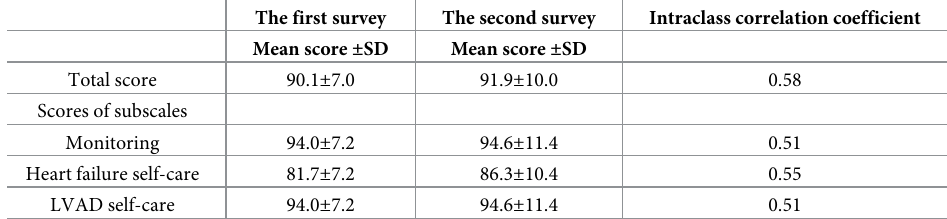
Table 5. Test-retest reliability of the 20-item LVAD self-care behaviour scale (n =